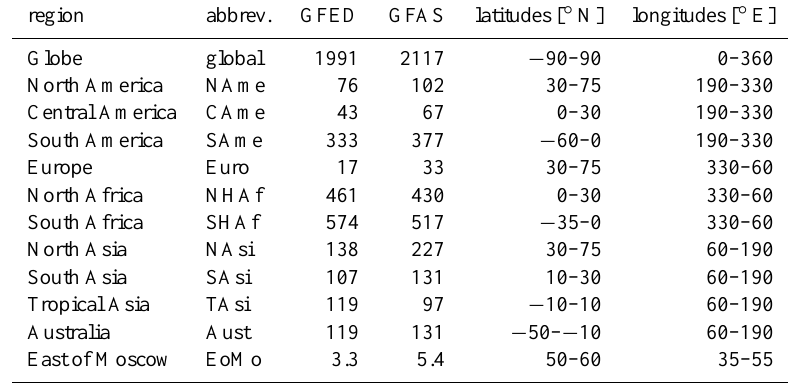
Table 4. Average global and regional combustion budgets [Tg(C)a − 1 ] during 2003–2008 in GFED3.1 and